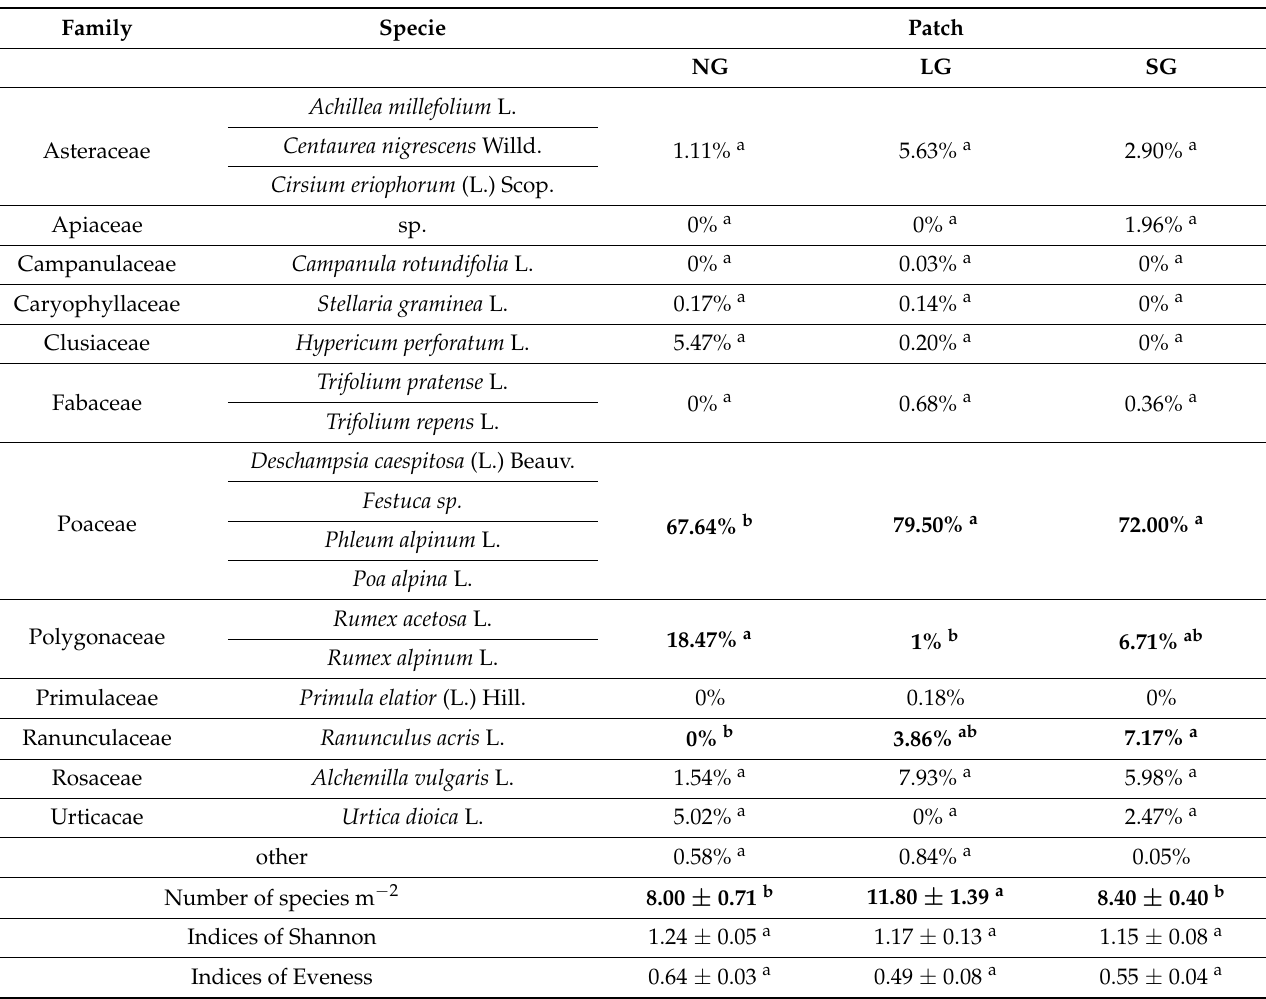
Table 1. Relative abundances of the botanical families in NG, LG and SG plots calculated on the basis of species biomass and diversity indices (average ± standard